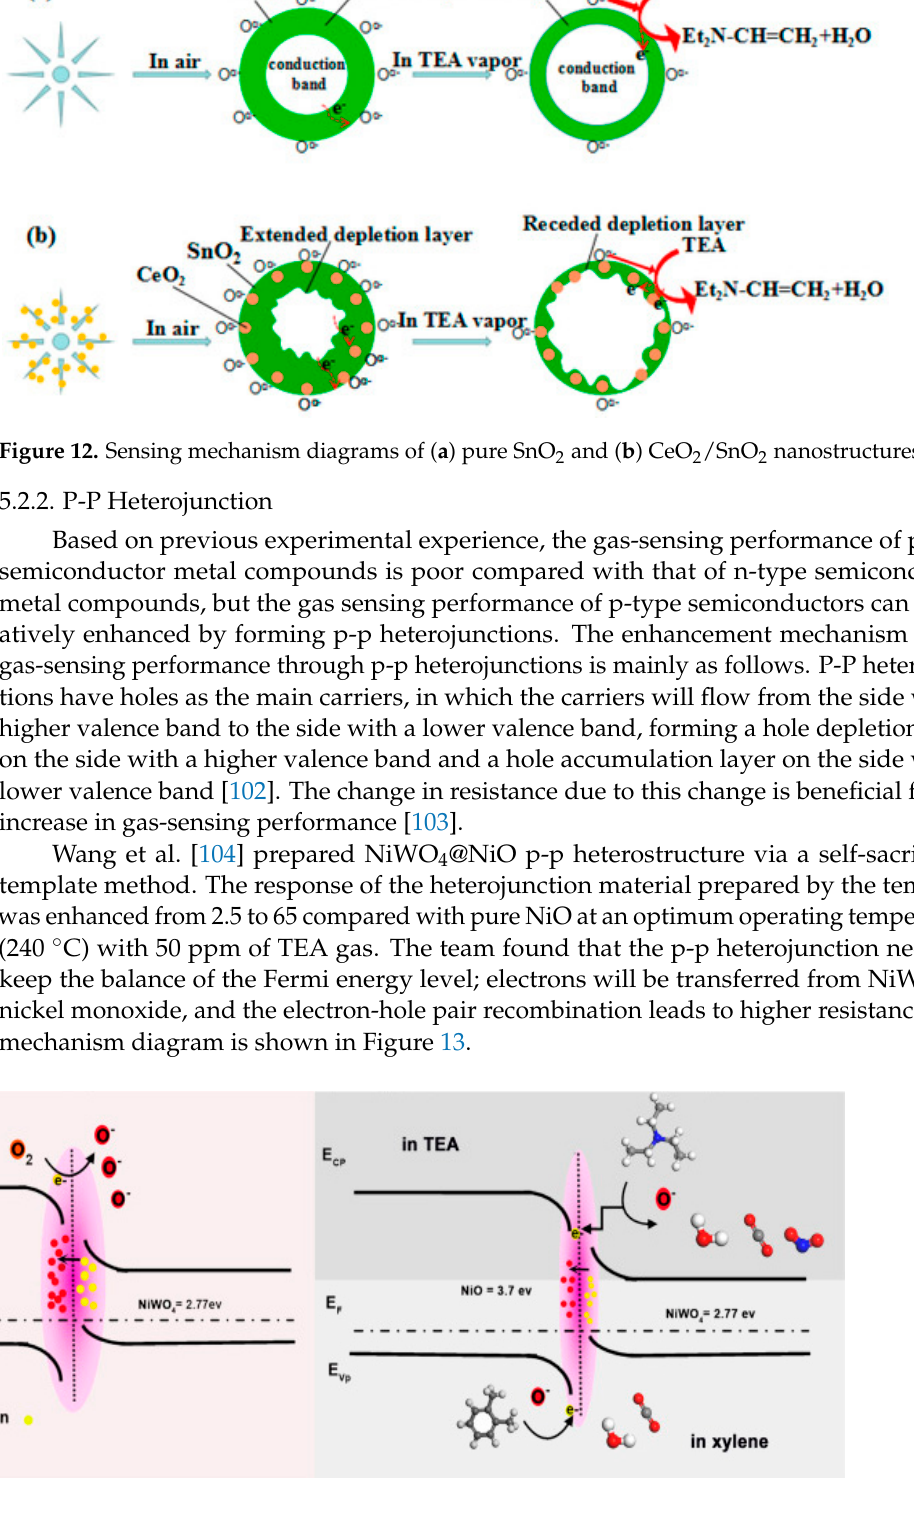
Figure 12. Sensing mechanism diagrams of ( a ) pure SnO 2 and ( b ) CeO 2 /SnO 2 nanostructures [101].